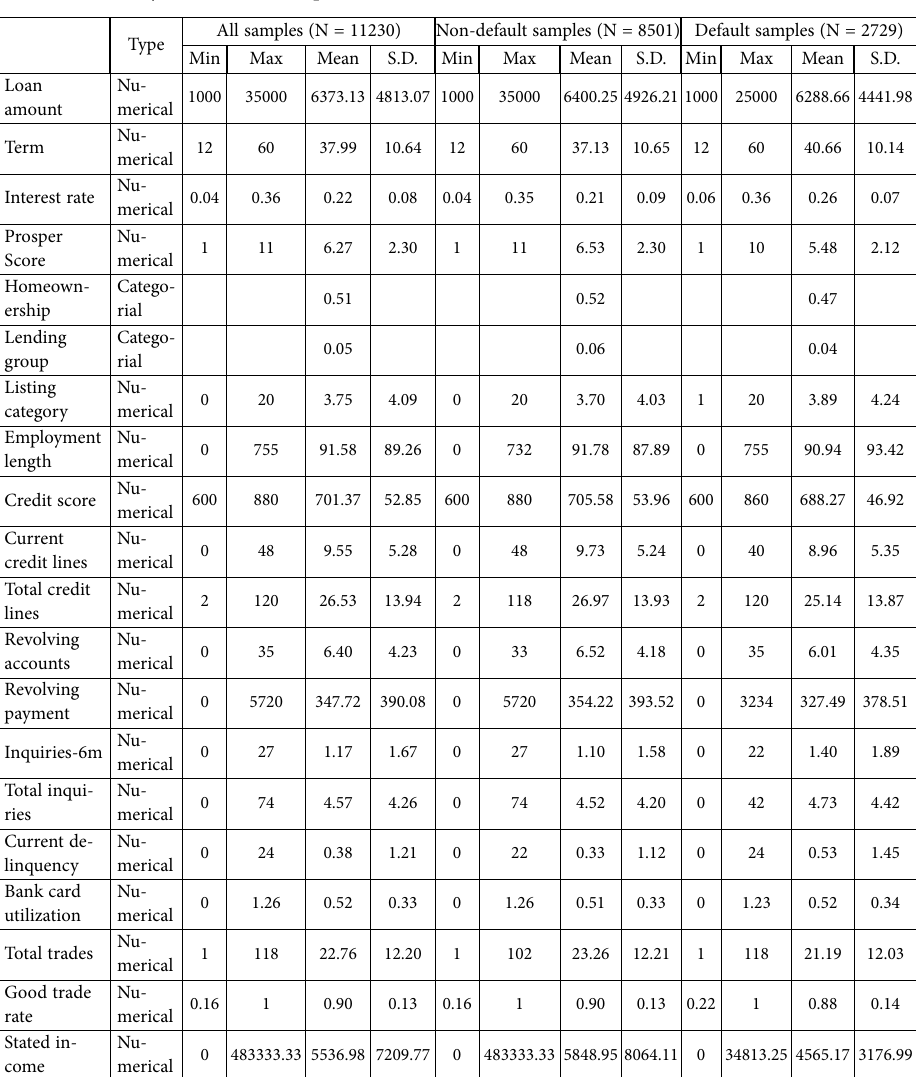
Table 2. Summary statistics of Prosper